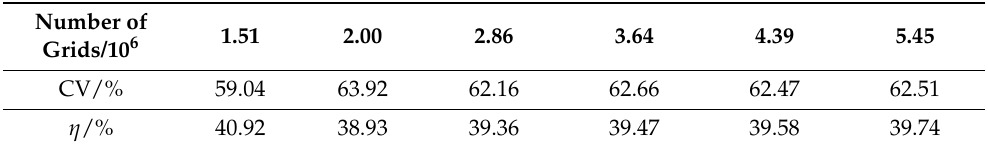
Table 1. Grid independence